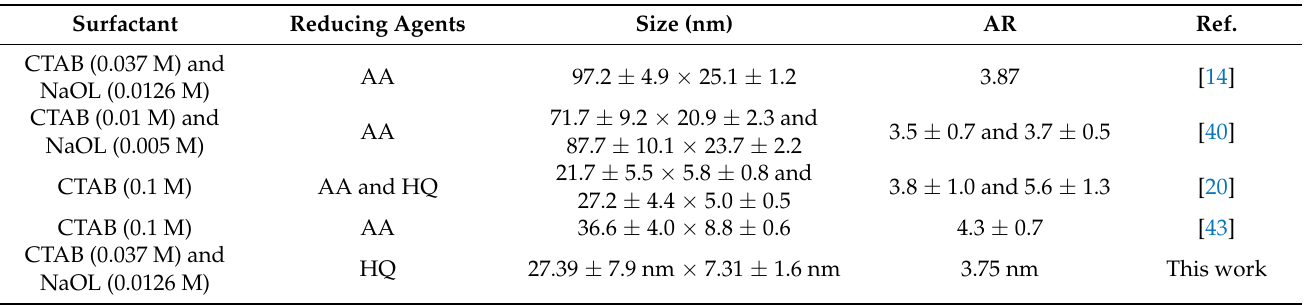
Figure 3. The relationship between HQ concentration and ( A ) LSPR band wavelengths and aspect ratio, ( B ) aspect ratio and rod length, and ( C ) aspect ratio and rod diameter. ( D ) Normalized UV-Vis-Vis spectra of AuNRs synthesized with 0.1 M HQ and, 0.050 mL, and 0.036 mL HCl with constant AgNO 3 concentration and seed solution. TEM images of AuNRs with 0.1 M HQ and ( E ) 0.050 mL or ( F ) 0.036 mL HCl, under constant AgNO 3 concentration and seed solution. Table 1. The comparison table of AuNRs’ size parameters (length, diameter, and aspect ratio) absorbing at ~800 nm from different seed-mediated syntheses.